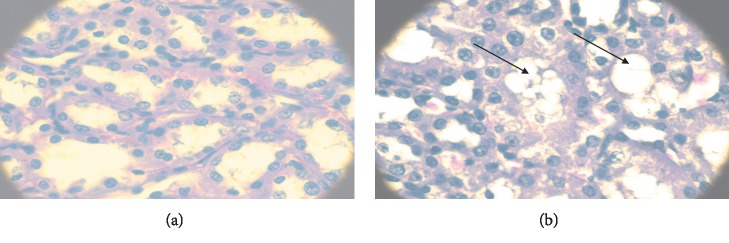
Comparison of histological sections of renal tissue of a healthy male Wistar rat (a) and a rat treated with C. ternifolia at 8.5 mg/kg (b) both with a haematoxylin and eosin stain. Spongiform changes are observed in the proximal tubules of the rat that received treatment (arrows).